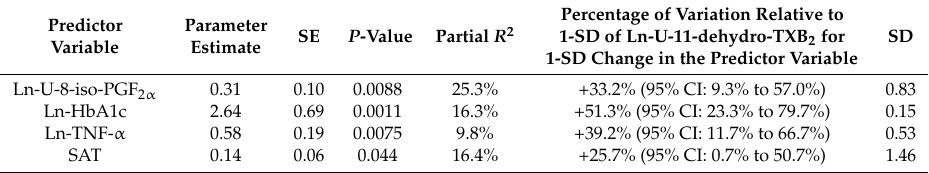
Table 2. Multivariable linear regression analysis (stepwise selection) for Ln-U-11-dehydro-TXB 2. Predictor